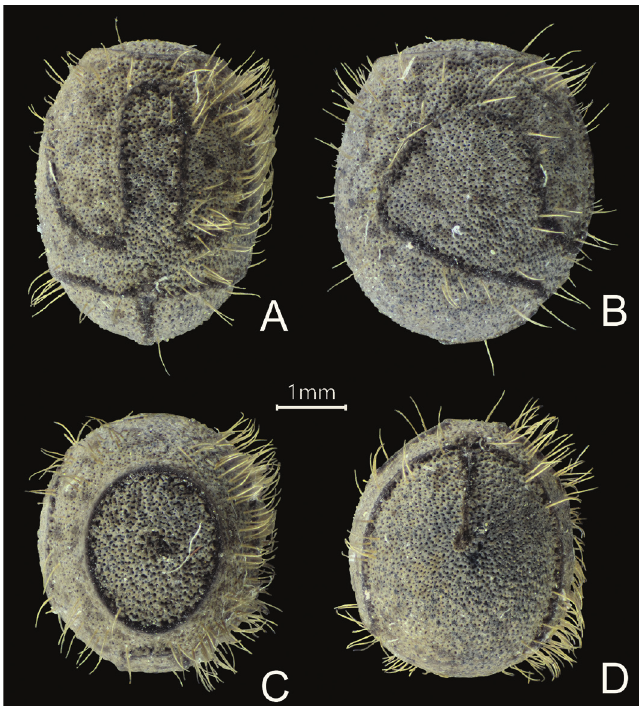
Fig. 2. Egg of Pylaemenes gulinqingensis sp. nov. A. Dorsal; B. Lat- eral; C. Operculum; D. Pole. Egg . Measurements [mm]: Length: 3.6; width: 3.3; height: 4.2. Capsule dark brown with dark spots, oval, posterior pole rounded; surface densely punctulate and sparsely covered with pale setae with a distal black structure. Operculum sub-circular, slightly convex. Micropylar plate tri-lobate with one anterior expansion and two posterior expansions like an inverse Y (Fig. 2A). The margin of micropylar plate darker and indistinctly raised. Median line dark and indistinctly